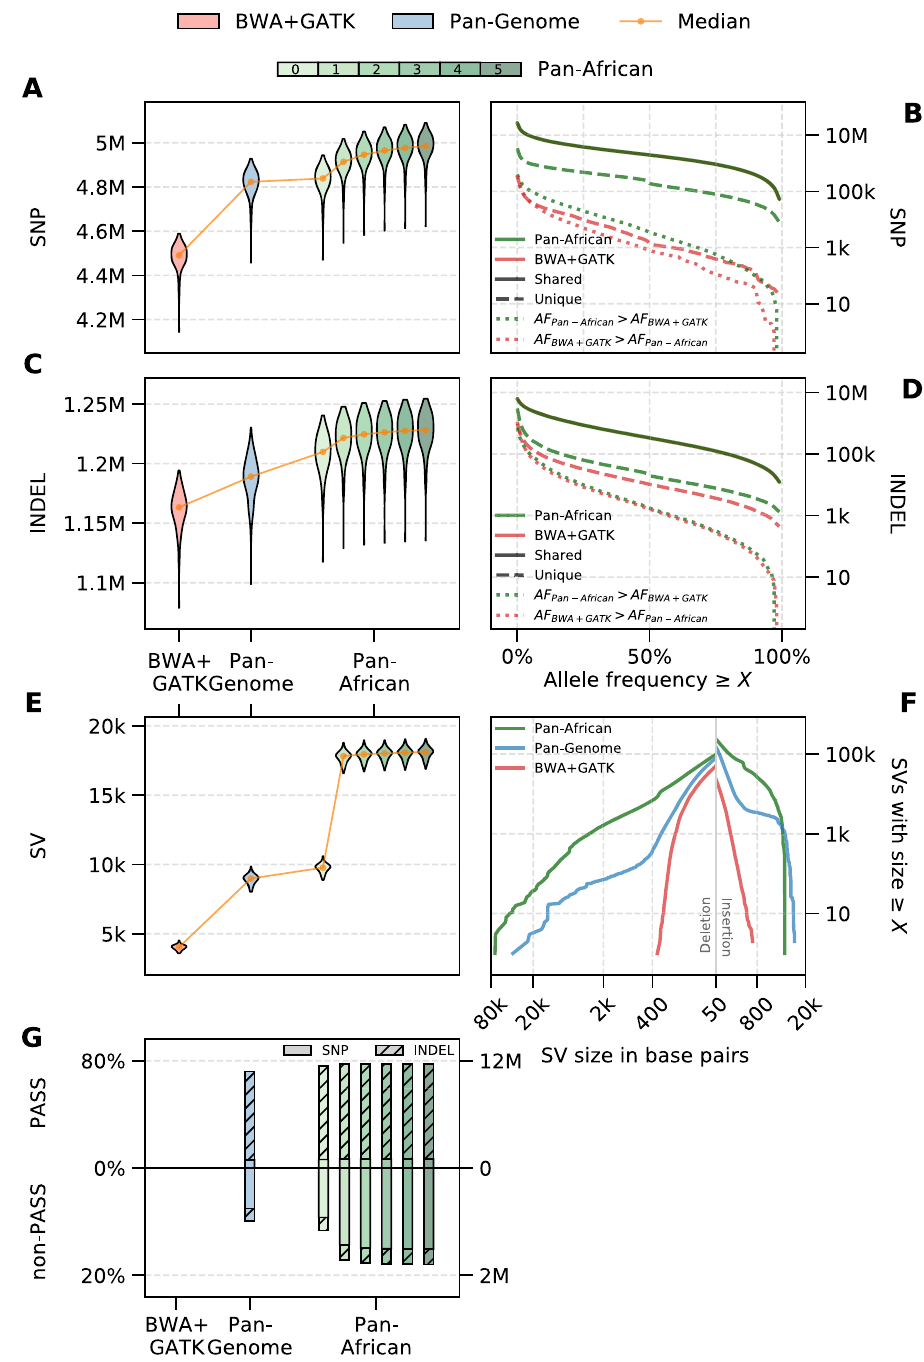
Fig. 4 Variant calling results for BWA + GATK (red), Pan-Genome (blue), and Pan-African Iterations (green). A Sample distribution of SNP counts, B cumulative AF distribution of SNPs separated into shared variants (solid lines), unique variants (dashed lines), and common variants with allele frequency difference (dotted lines), C INDEL counts, D cumulative AF distribution of INDELs separated into shared variants (solid lines), unique variants (dashed lines) and common variants with allele frequency difference (dotted lines), E structural variant (SV) counts, F size distribution of detected SVs, and G percentage of loci called by the graph pipeline for the variants rescued in the traditional joint calling (results are split based on the fi ltration output of VQSR). Two-sided Wilcoxon tests between consecutive distributions are performed for A , C , and E . In all cases, the difference is signi fi cant ( p < 10 − 21 ). Source data are provided as a Source Data fi